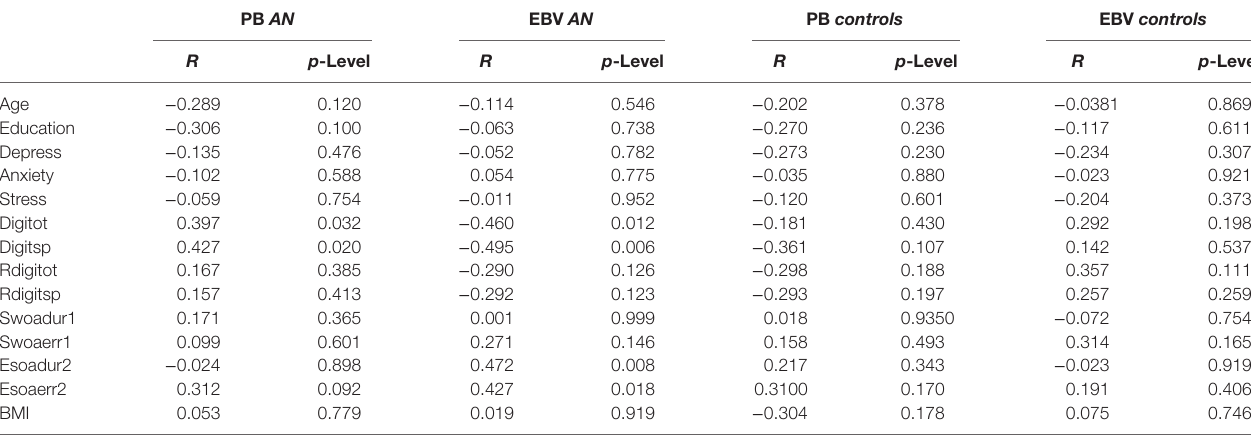
Table 2 | The table provides details about the correlation results between the PB and estimation bias variability (EBV) scores of the AN and the control groups and their performance with regard to clinical and cognitive measures.